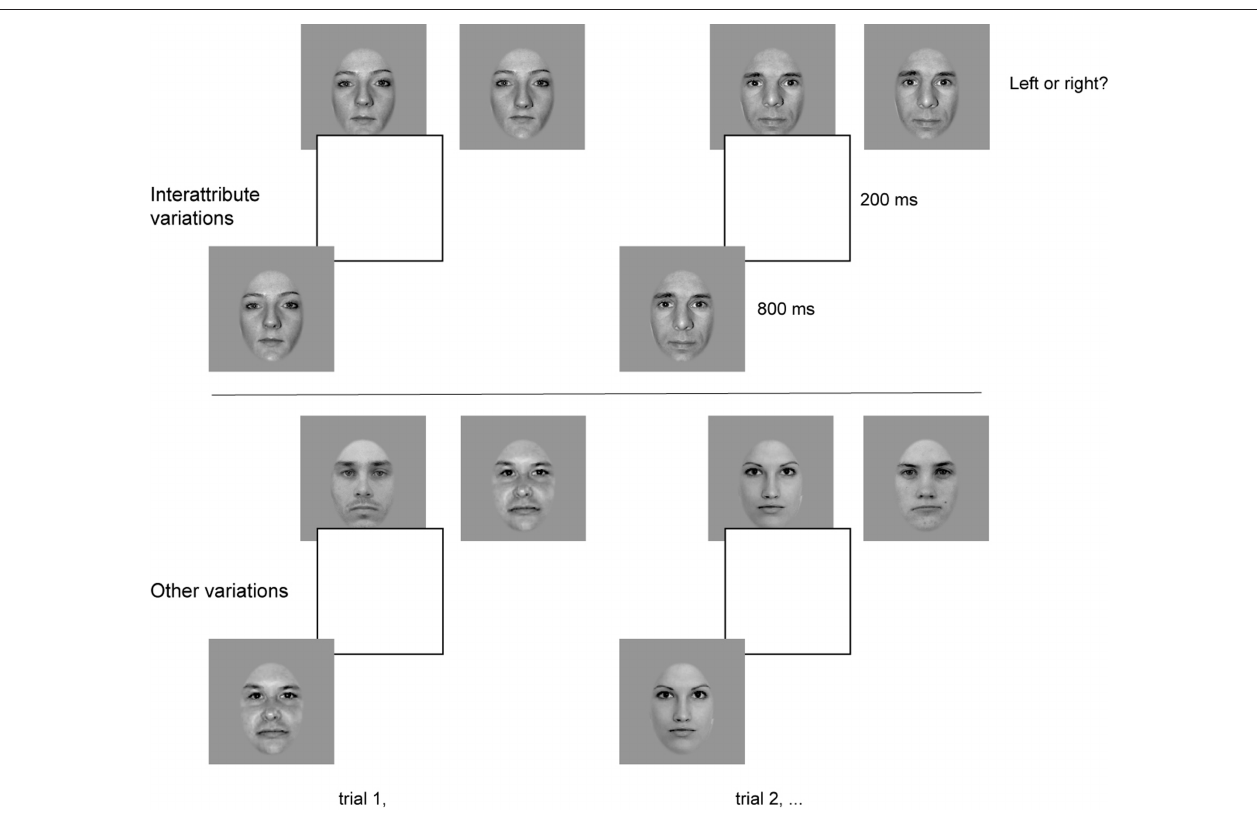
Figure 4 | Sequence of events in two sample trials of our experiments. Top: In Experiment 2a, we asked whether human observers can use this real-world interattribute distance information, at different viewing distances, to resolve a matching-to-sample (ABX) task when interattribute distance is the only